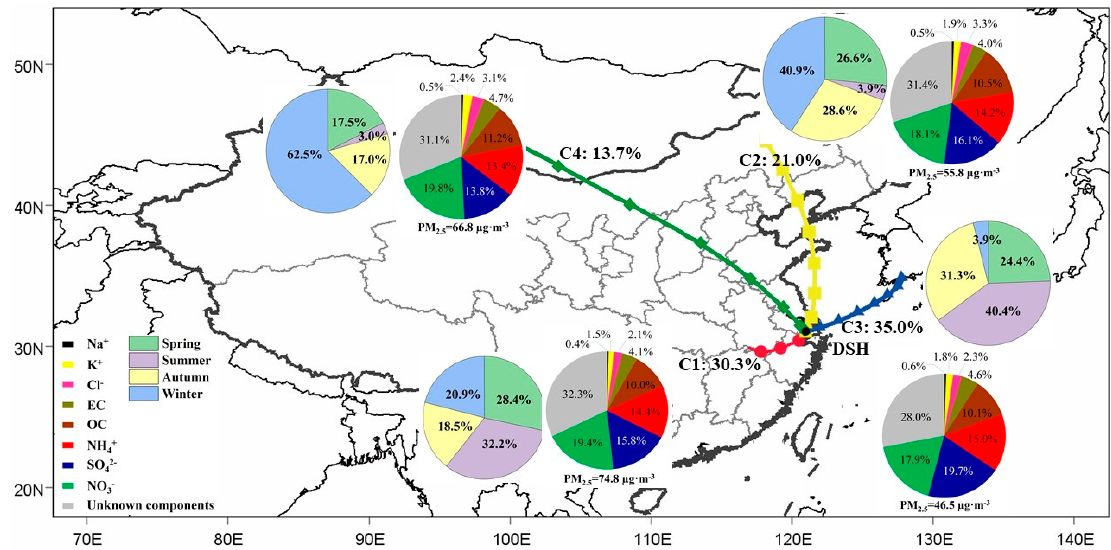
Figure 5. Seventy-two-hour air mass backward trajectories during the sampling period.